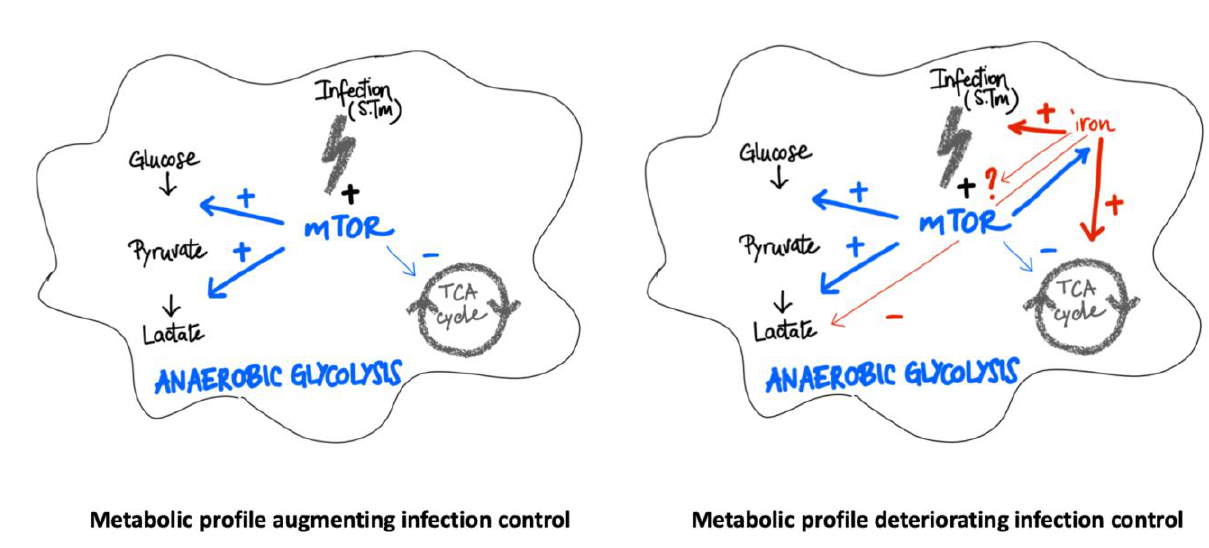
FIGURE 8: Scheme of interactions between iron, mTOR and metabolic activity in macrophages upon Salmonella infection. Left panel: Upon infection mTOR stimulates the Warburg pathway causing promotion of anaerobic glycolysis whereas citric acid cycle activity (TCA) is reduced resulting in improved control of infection with intracellular bacteria such as Salmonella . Right panel: Increased abundance of iron in cells activates the TCA cycle but reduces anaerobic glycolysis resulting in a presumably pathogen friendly nutritional environment. In addi- tion, iron is an essential nutrient for Salmonella and may feed bacteria directly. To which extend iron and mTOR interact directly or indirect- ly remains to be shown although blockage of the mTOR pathway even further stimulated the growth promoting effects of iron on Salmonel- la